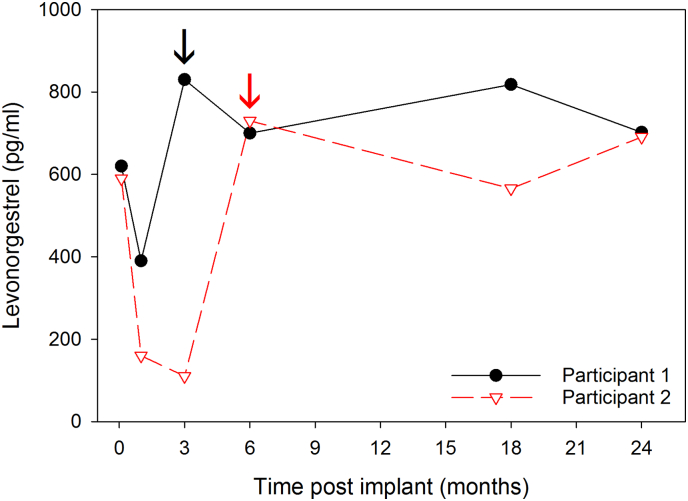
Levonorgestrel concentrations rebound after stopping efavirenz among two HIV-infected levonorgestrel implant users who switched to a nonefavirenz-based antiretroviral therapy regimen.Legend: Levonorgestrel concentrations for two users undergoing switching to a nonefavirenz-based antiretroviral therapy regimen after having received the implant are plotted over time. Color-coded arrows correspond to the first study visit occurring after the switch from efavirenz. In both instances, serum levonorgestrel concentrations rebound above baseline concentrations.